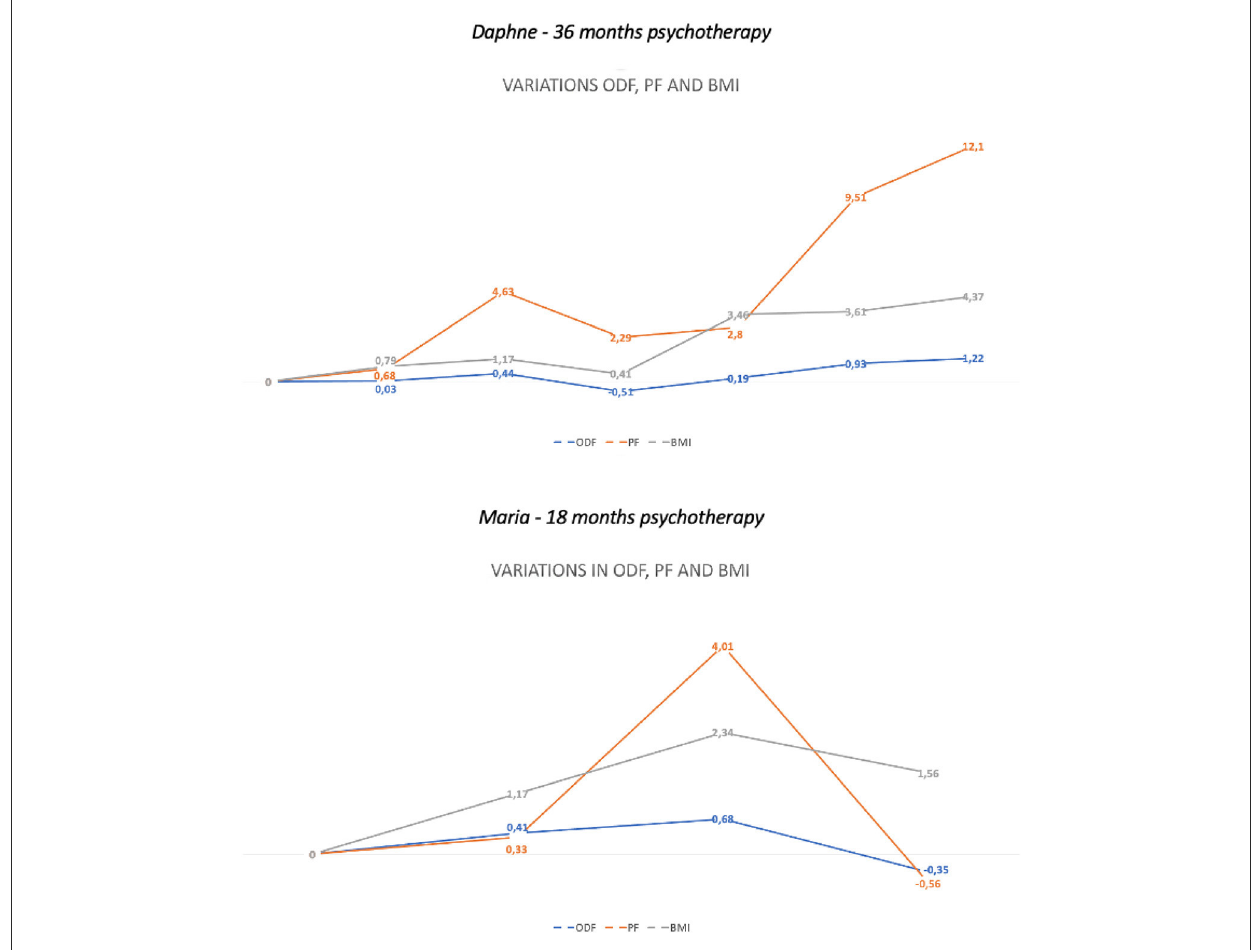
FIGURE1 Changes in ODF, PF, and BMI during